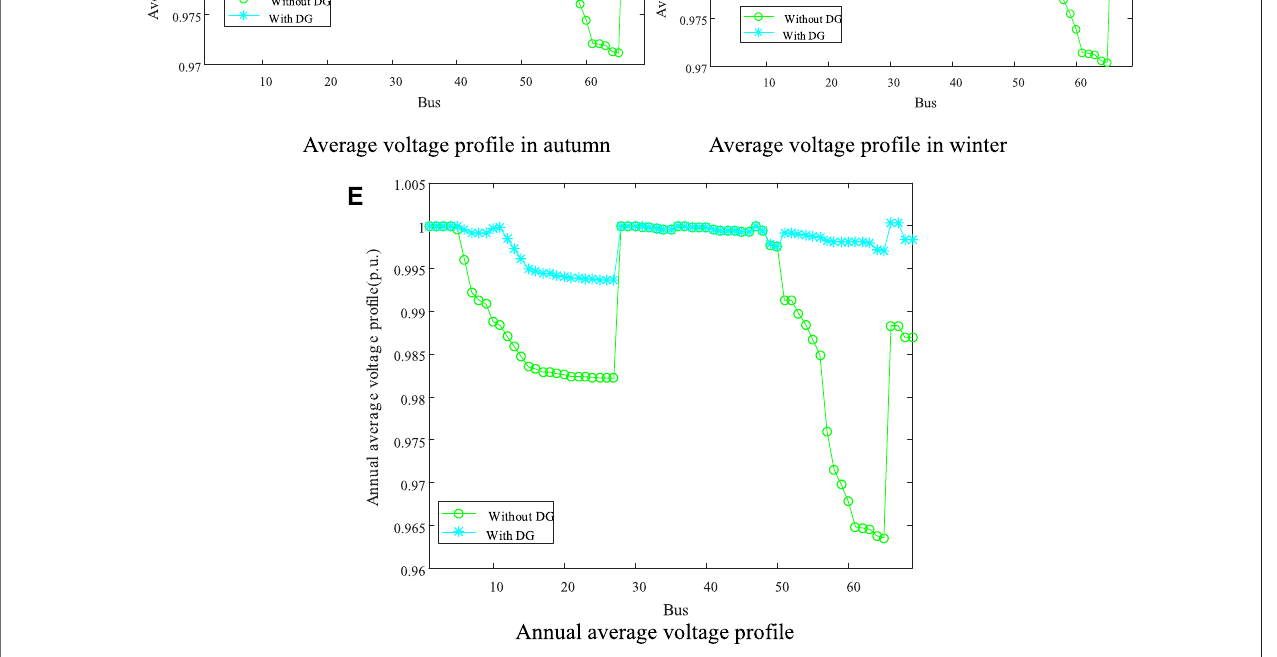
FIGURE 8 | Voltage pro fi le improvement of the IEEE 33-bus distribution network. (A) Average voltage pro fi le in spring. (B) Average voltage pro fi le in summer. (C) Average voltage pro fi le in autumn. (D) Average voltage pro fi le in winter. (E) Annual average voltage pro fi le.